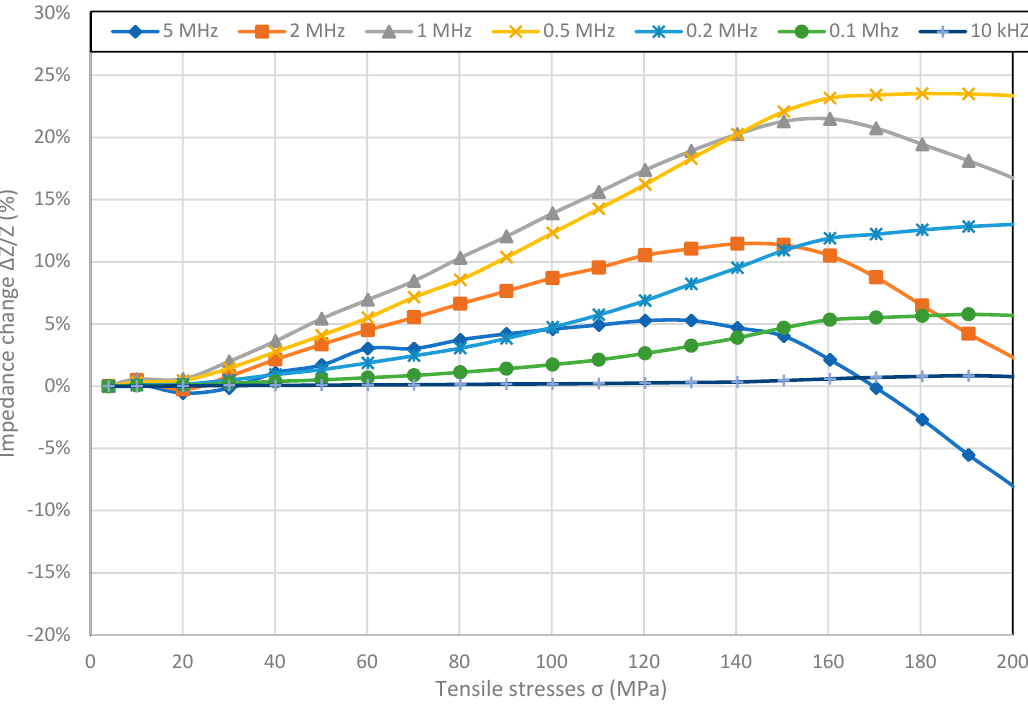
Figure 4. Dependence of sample Co 70 Fe 5 Ni 2 Mo 5 B 3 Si 15 impedance on tensile stress σ . Materials 2019 , 12 , x FOR PEER REVIEW